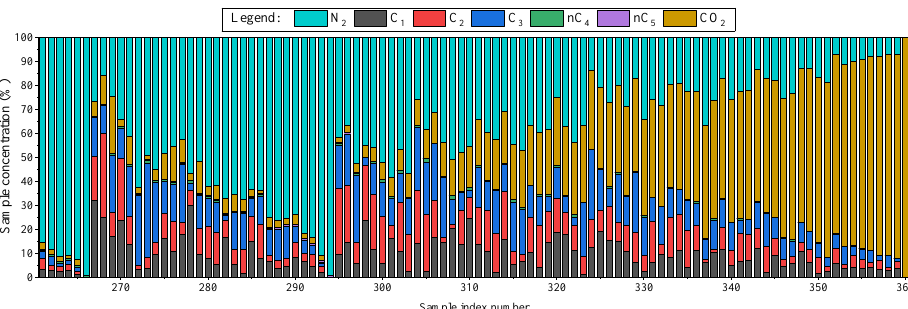
Figure 5. The concentration value of each sample in the six-component